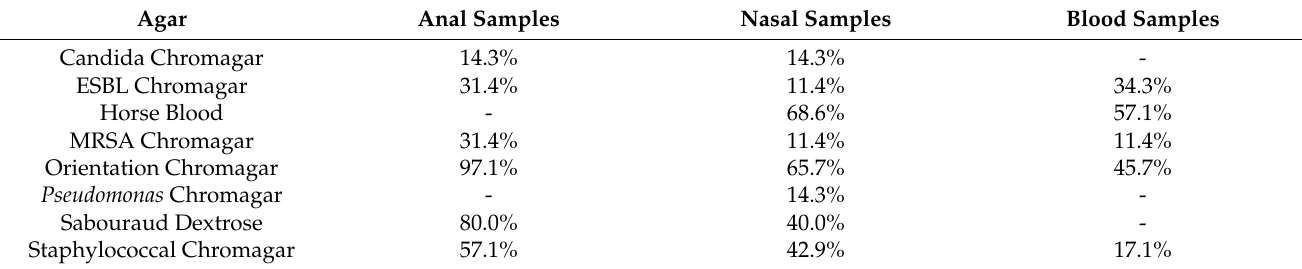
Table 3. Distribution of bacteria from the different sample sites.